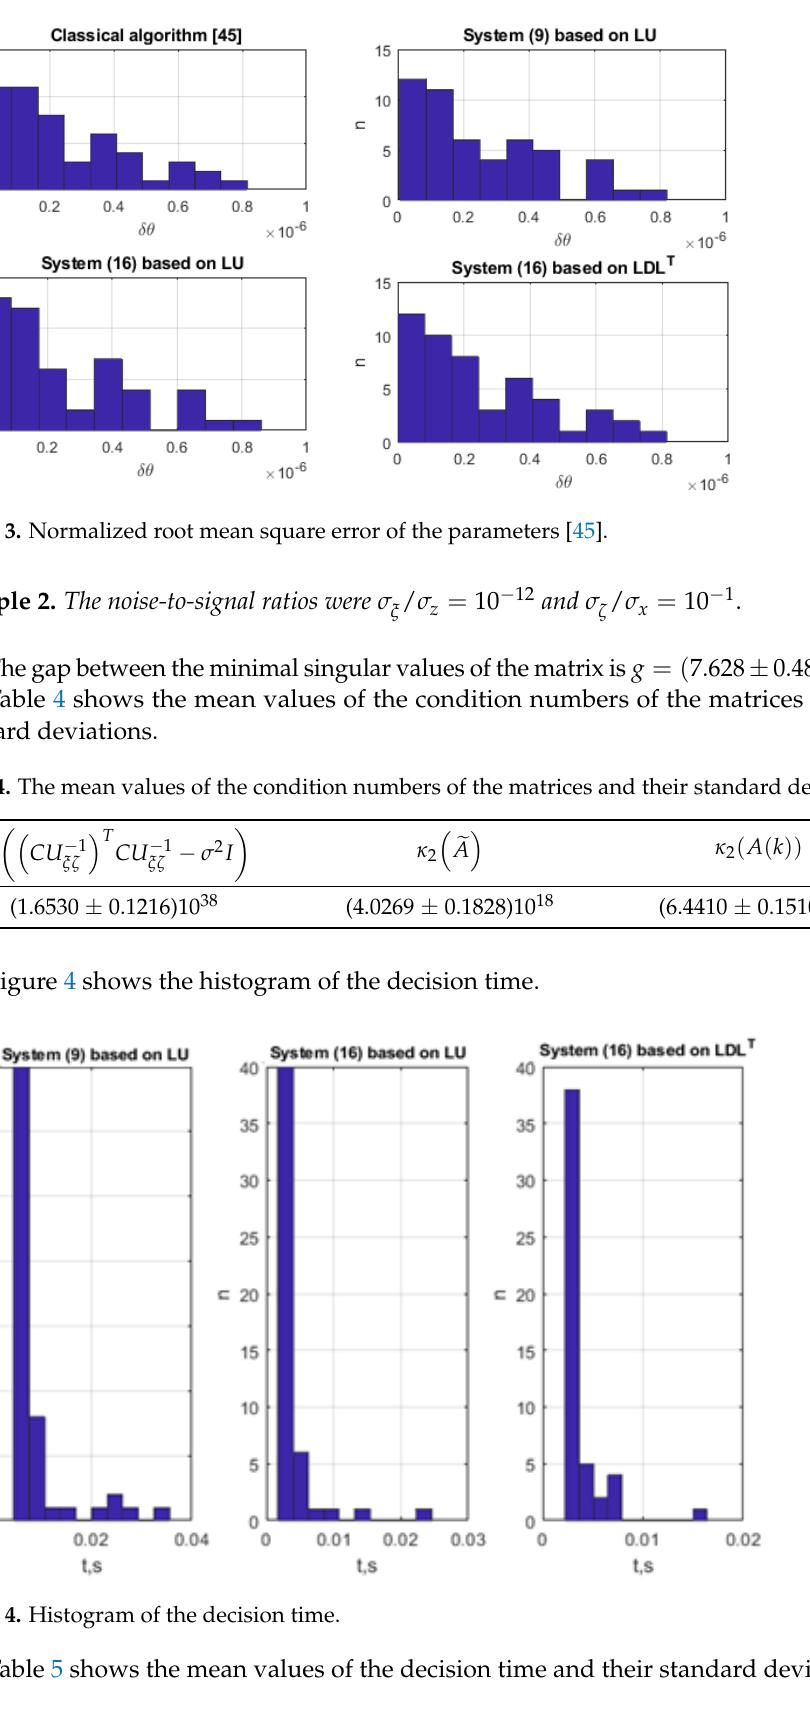
Table 3. The mean values of the normalized root mean square error of the parameter estimation and their standard deviations.